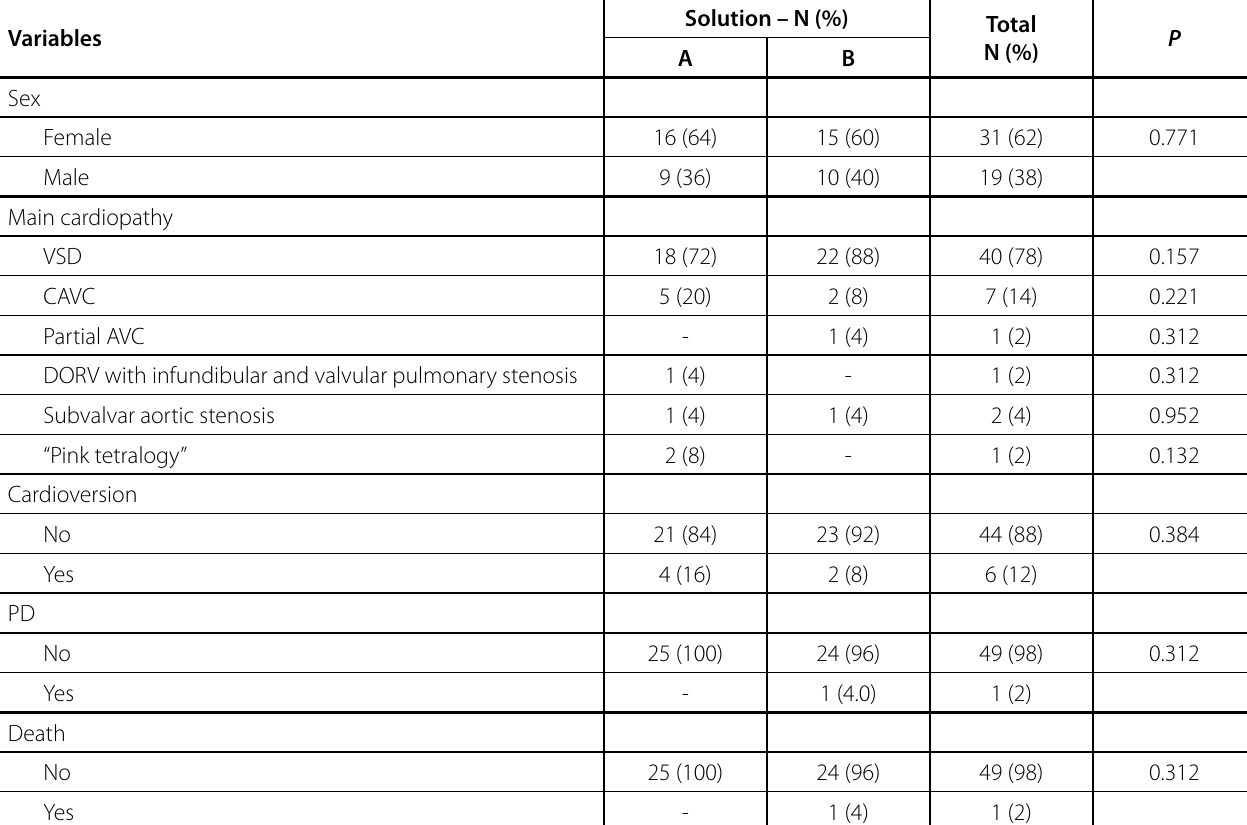
Table 2 . Distribution of categorical variables according to the